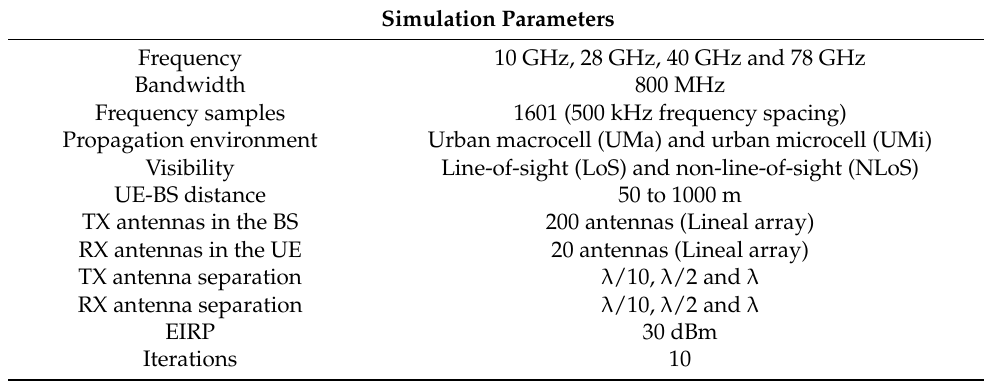
Table 2. NYUSIM simulation